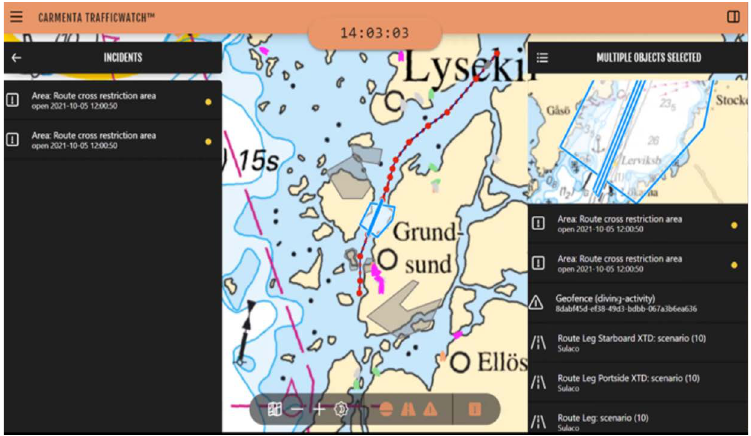
Figure A1. The Graphical User Interface.